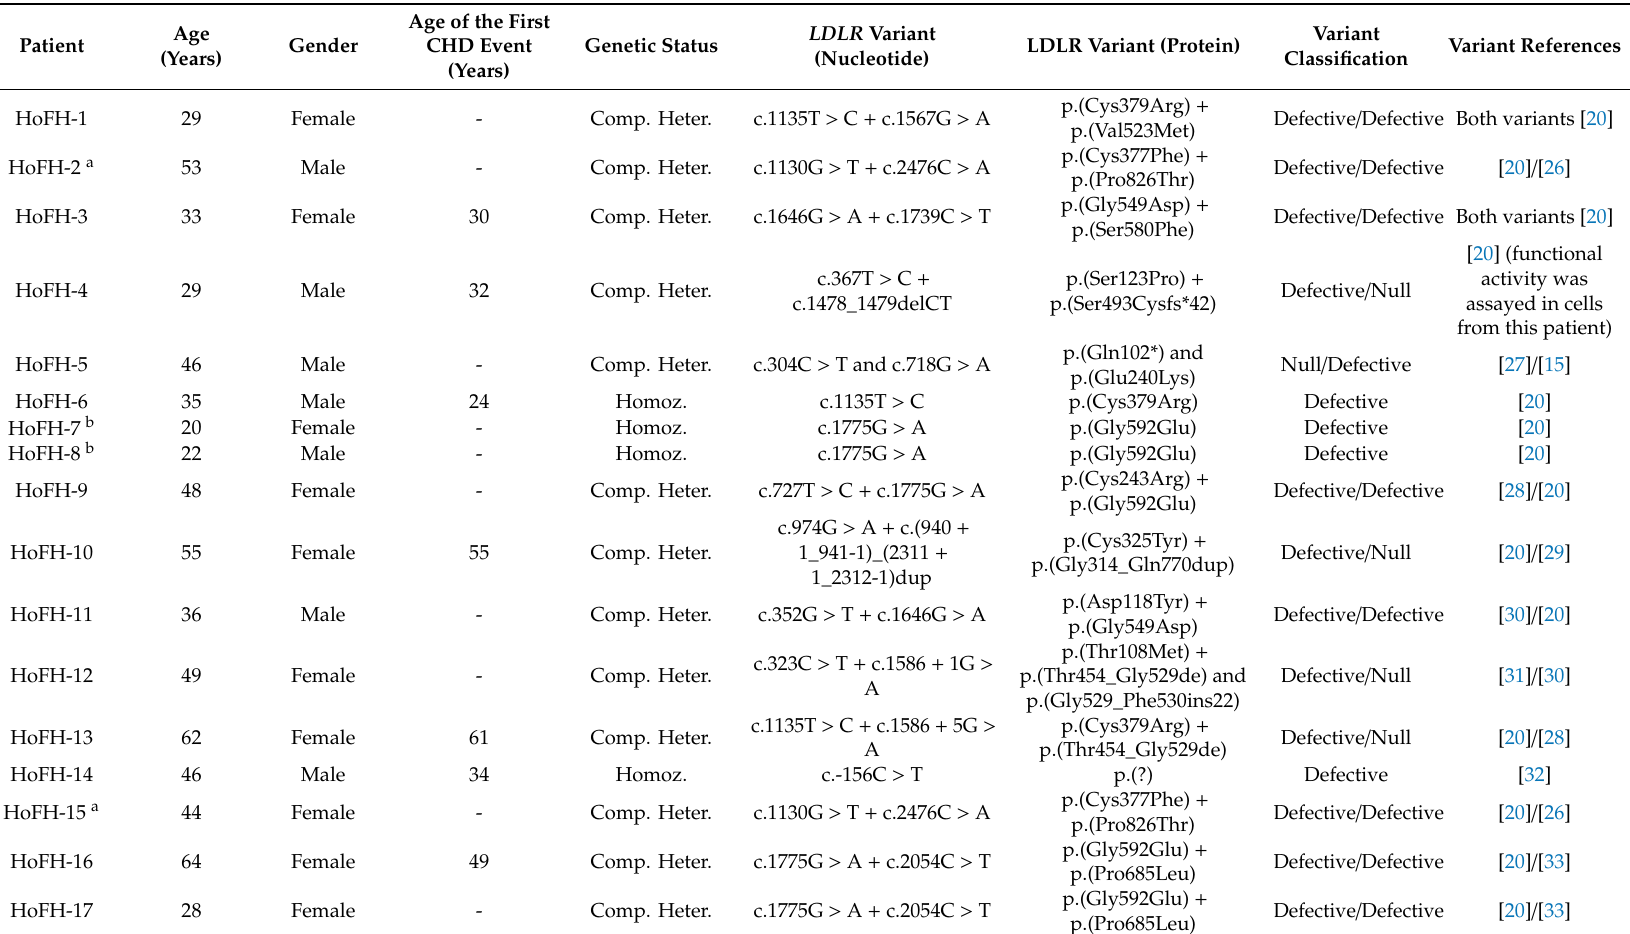
Table 1. Genetics, ages, and familial relations of the 23 patients with homozygous familial